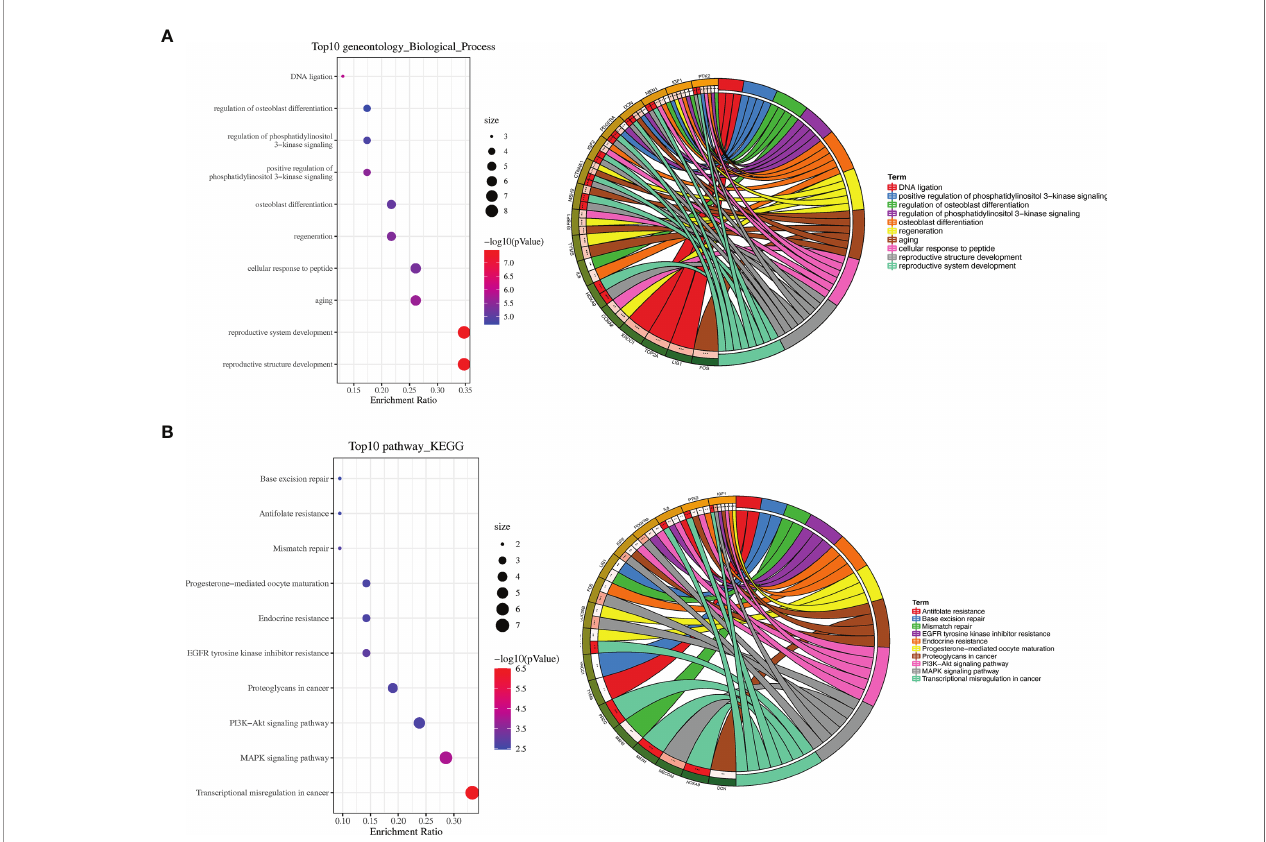
FIGURE 2 | GO and KEGG pathway enrichment analyses. (A) Bubble plot of biological processes enrichment analysis of DEGs and circle plot of biological processes enrichment analysis of DEGs. (B) Bubble plot of KEGG pathway enrichment analysis of DEGs and circle plot of KEGG pathway enrichment analysis of DEGs. *P < 0.05, **P < 0.01, and ***P <